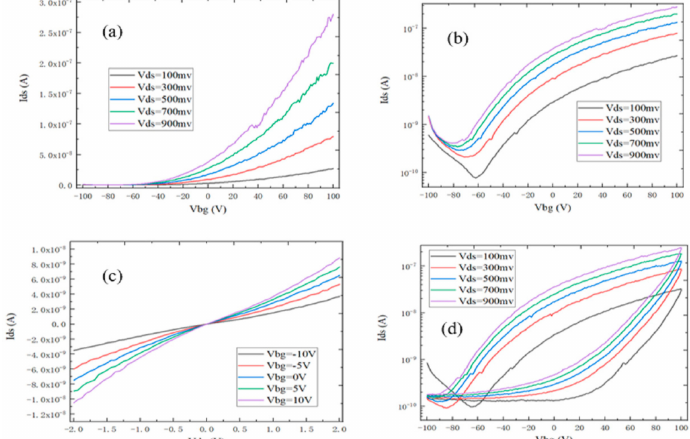
Figure 6. The monolayer MoS 2 -based back-gate FET. ( a ) The I ds –V bg transfer curve; ( b ) the I ds –V bg transfer curve with the ordinate semi-logarithmic coordinate; ( c ) the I ds –V ds output curve; and ( d ) the hysteresis loop of MoS 2 FET under di ff erent V ds